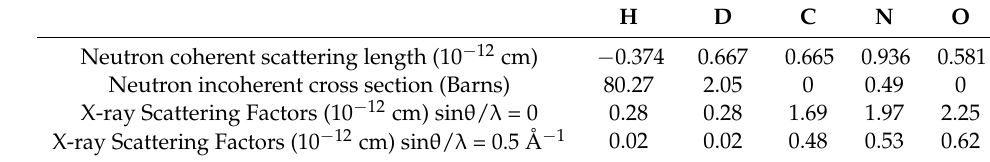
Table 1. Neutron scattering lengths and X-ray scattering factors for atoms in biological macromolecules.